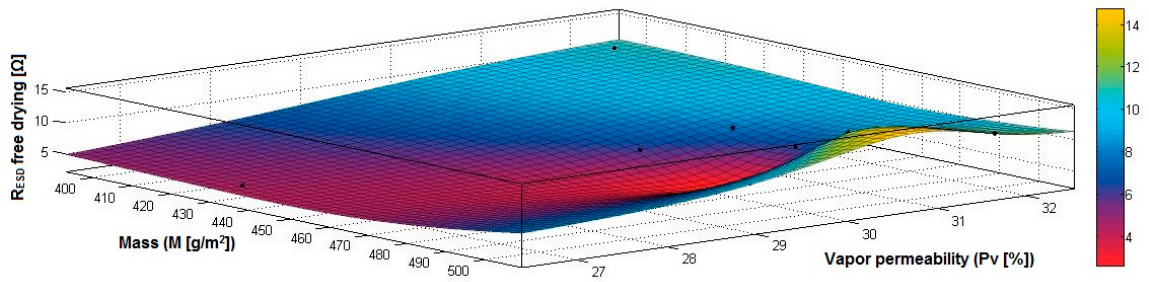
Figure 24. 3D representation R ESD free drying = f(M, Pv) for samples preliminarily treated in RF plasma O 2 using RF 1 generator and power 200 W.